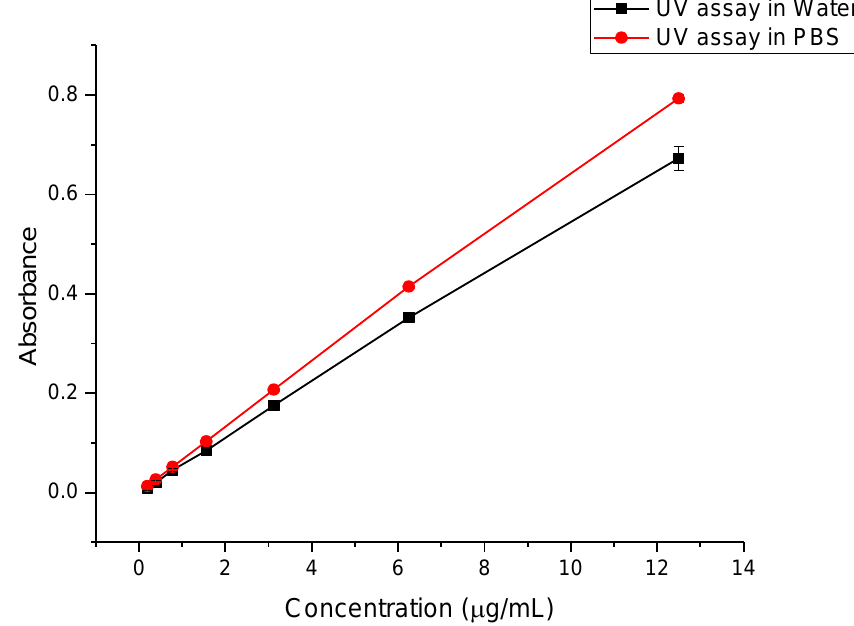
Figure 6. Halicin UV calibration curves using deionized water (DW) (for drug loading (DL) determination) and phosphate buffer saline (PBS) pH 7.4 (for the release study). Both curves showed good linearity at a concentration range of 12.5 to 0.2 μg/mL, with the r 2 of 0.9994 and 0.9995 for DW and PBS, respectively.